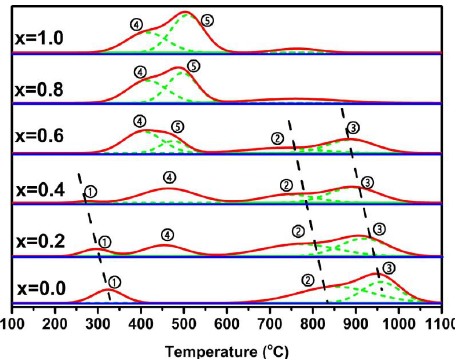
Figure 4. TPR profiles of fresh La 1-x Ce x Ni 0.5 Fe 0.5 O 3 with different x values. Reproduced with permission from reference [106].